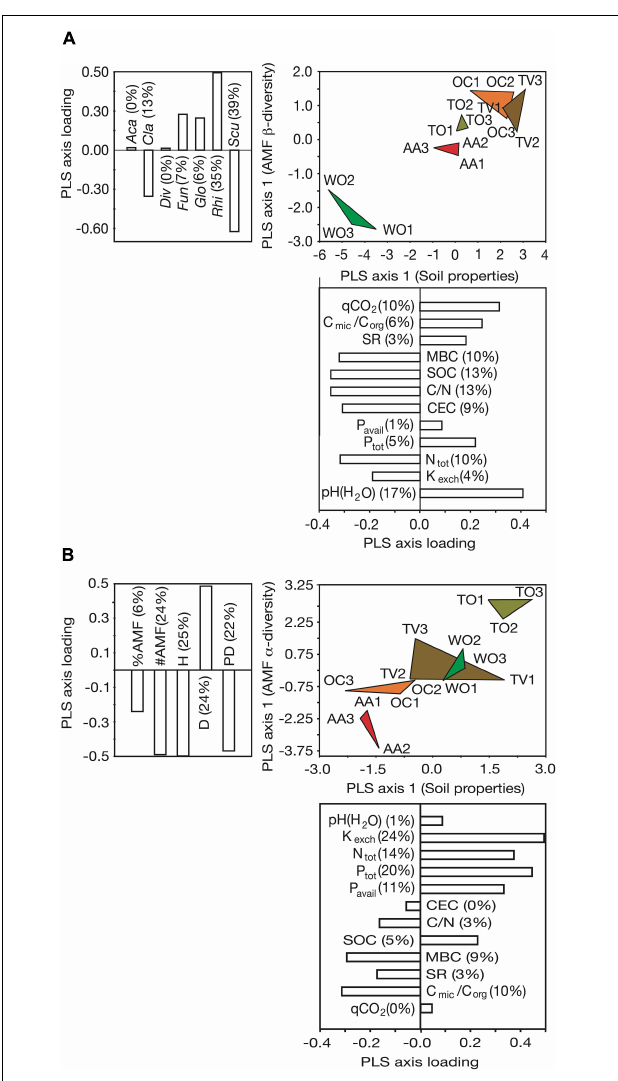
FIGURE 4 | Partial least square (PLS) ordination plots separating five land-use types along the first ordination axes of soil microbiological and chemical properties and α - and β -diversity of arbuscular mycorrhizal fungal (AMF) communities at the genus level. (A) Ordination along the PLS axes of AMF β -diversity and soil microbiological and chemical properties and (B) ordination along the PLS axes of AMF α -diversity and soil microbiological and chemical properties. Three fields on different farms were analyzed per land-use type. The magnitude of influence (PLS axis loading) of the explanatory variables is indicated in the form of bar plots next to the ordination axes. The percentage contribution of the individual variables to the variance resolved by the respective ordination axis is indicated in brackets. See Figure 1 for land-use abbreviations. The AMF genera were: Aca , Acaulospora Gerd. and Trappe; Cla , Claroideoglomus C. Walker and A. Schüßler; Div , Diversispora C. Walker and A. Schüßler; Fun , Funneliformis C. Walker and A. Schüßler; Glo , Glomus Tul. and C. Tul.; Rhi , Rhizophagus P.A. Dang; Scut , Scutellospora C. Walker and F.E. Sanders. #AMF, number of AMF genera; %AMF, percentage of root colonization by AMF; CEC, cation exchange capacity; C mic /C org , microbial:soil organic carbon ratio; C/N, carbon:nitrogen ratio; D, dominance of AMF at the genus level; H, Shannon diversity of AMF at the genus level; K exch , exchangeable potassium; N tot , total nitrogen; PD, phylogenetic diversity